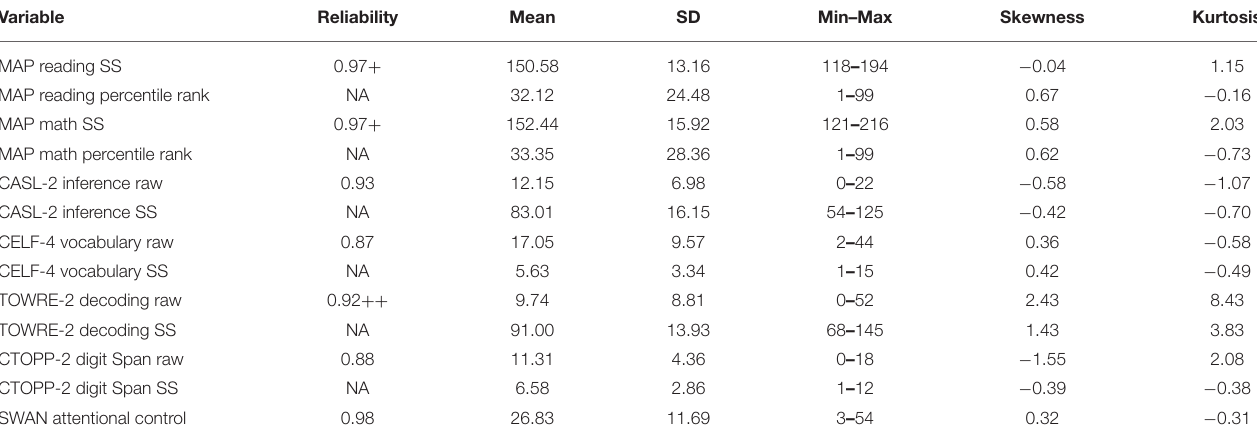
TABLE 1 | Descriptive